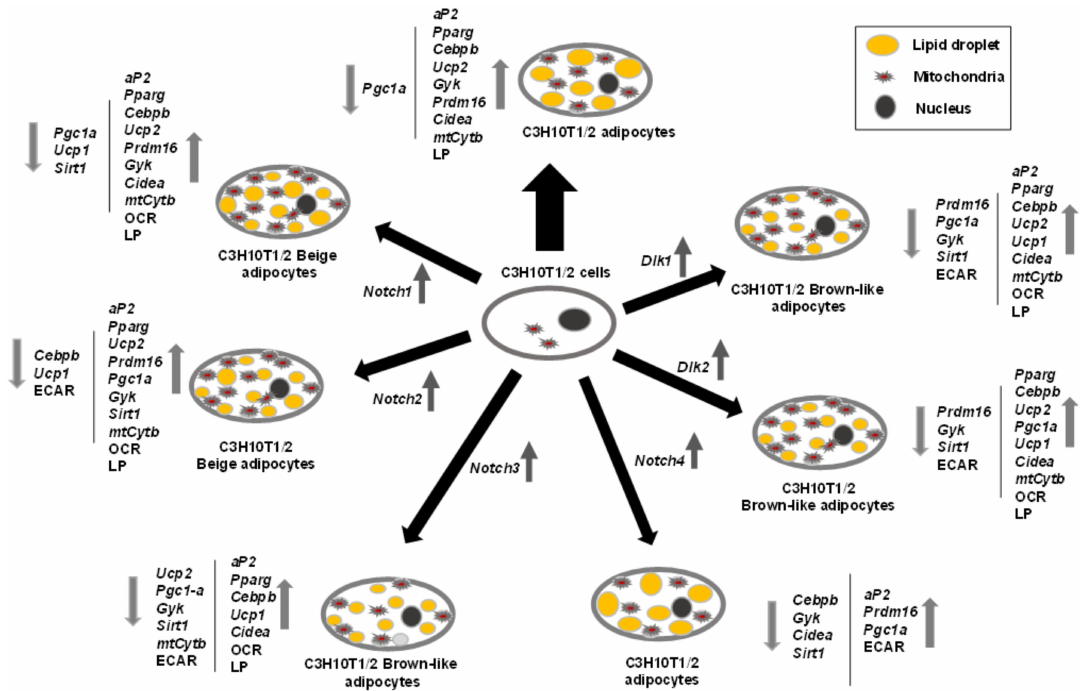
Figure 8. Outline of the roles of Notch and Dlk genes’ overexpression on C3H10T1 / 2 adipogenesis. The e ff ects of adipogenic inductors at the end of the di ff erentiation process (2 days with dexamethasone and IBMX (3-Isobutyl-1-methylxanthine) and 5 days with insulin) on C3H10T1 / 2 cells (wide black arrow) are compared to the e ff ects of the same adipogenic inductors on C3H10T1 / 2 cells stably overexpressing each of the Notch or Dlk genes. The direction (up or down) of the variations in the expression levels of adipogenic markers, brown adipocyte markers, mitochondrial biogenesis markers, and metabolic e ff ects are shown by grey arrows. OCR: oxygen consumption rate, ECAR: extracellular acidification rate, LP: lipolytic